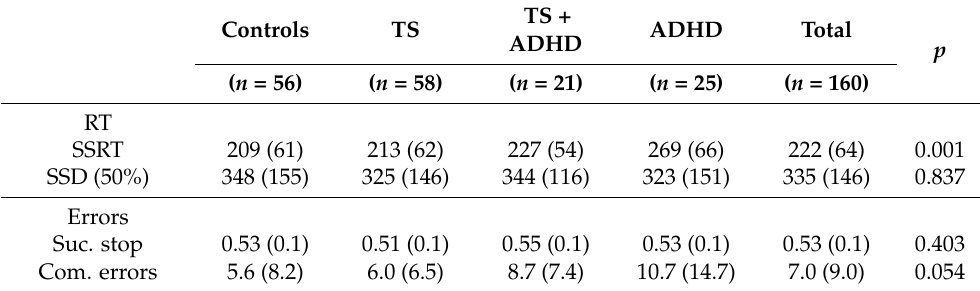
Table 2. Group differences in the stop signal